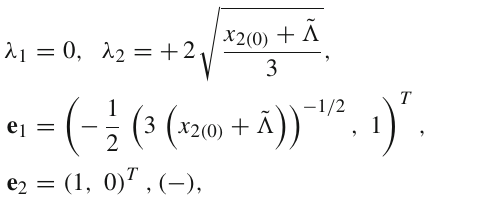
x 1 and x 2 respectively denote the dimensionless ˜ H and ˜ ρ as defined in Eq. (7). X and Y are the coordinates on the Poincaré sphere as defined (cid:12) (cid:11) (cid:12) (cid:11) (cid:12) in Eq. (47). The dotted circles represent fixed ω = − 3 ω = − 2 , ˜ (cid:4) = − 1 , ˜ (cid:4) = − 1 , and . 2 2 2 3 2